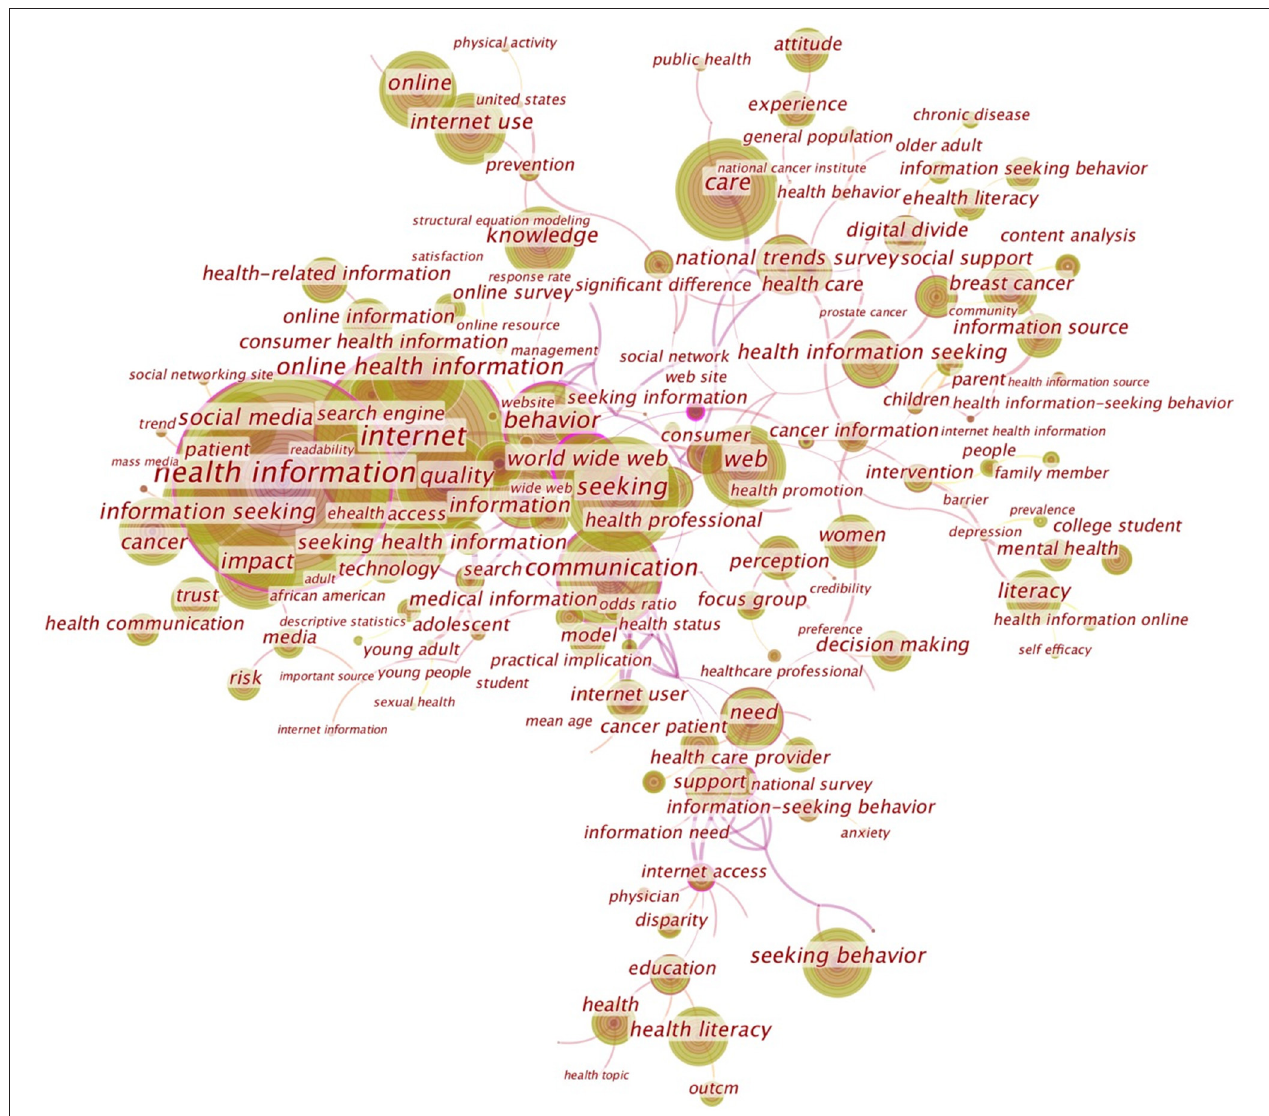
FIGURE 3 | Keyword co-occurrence mapping of online health information seeking behavior research.